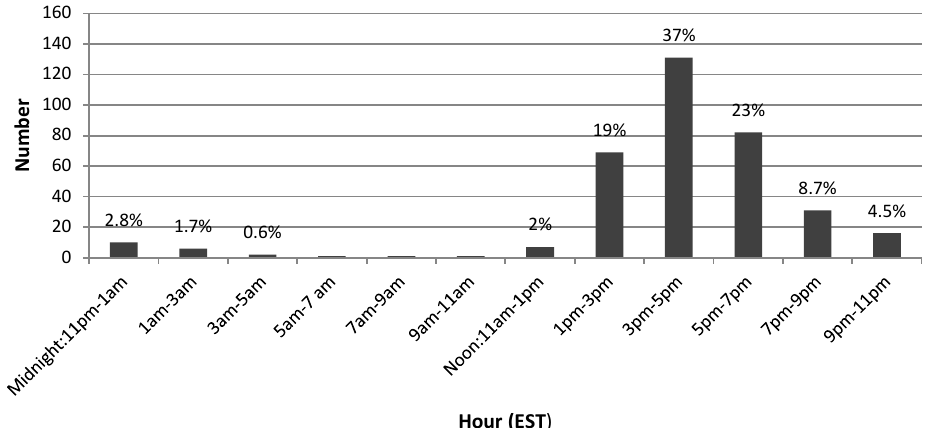
Figure 2. Diurnal distribution of hail events in the GMSTWA during 1989–2013.